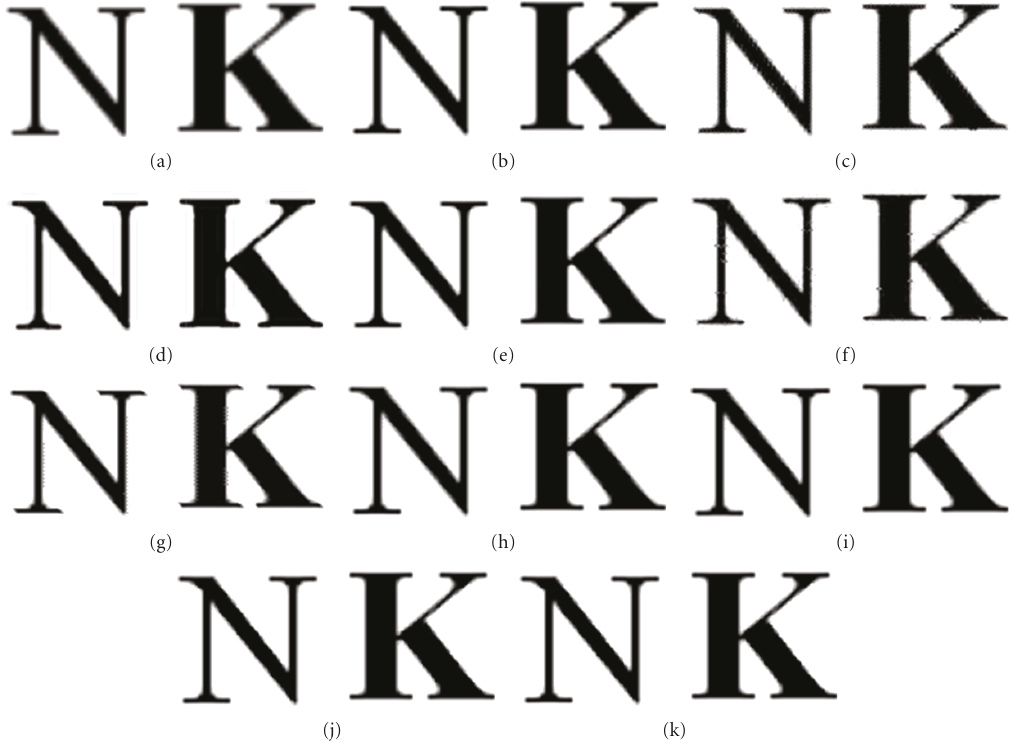
Figure 14: Resolution enhanced English letters “NK” by (a) bilinear; (b) bicubic; (c) edge-directed method ( M = 8) [12]; (d) ICBI [20]; (e) LMMSE-based method ( ζ = 1, ξ = 1 . 5) [17]; (f) SAI ( λ = 0 . 5) [18]; (g) NN-based method [16]; the proposed method utilized (h) bilinear kernel and (i) bicubic kernel without edge enhancement; (j) bilinear kernel and (k) bicubic kernel with edge enhancement.